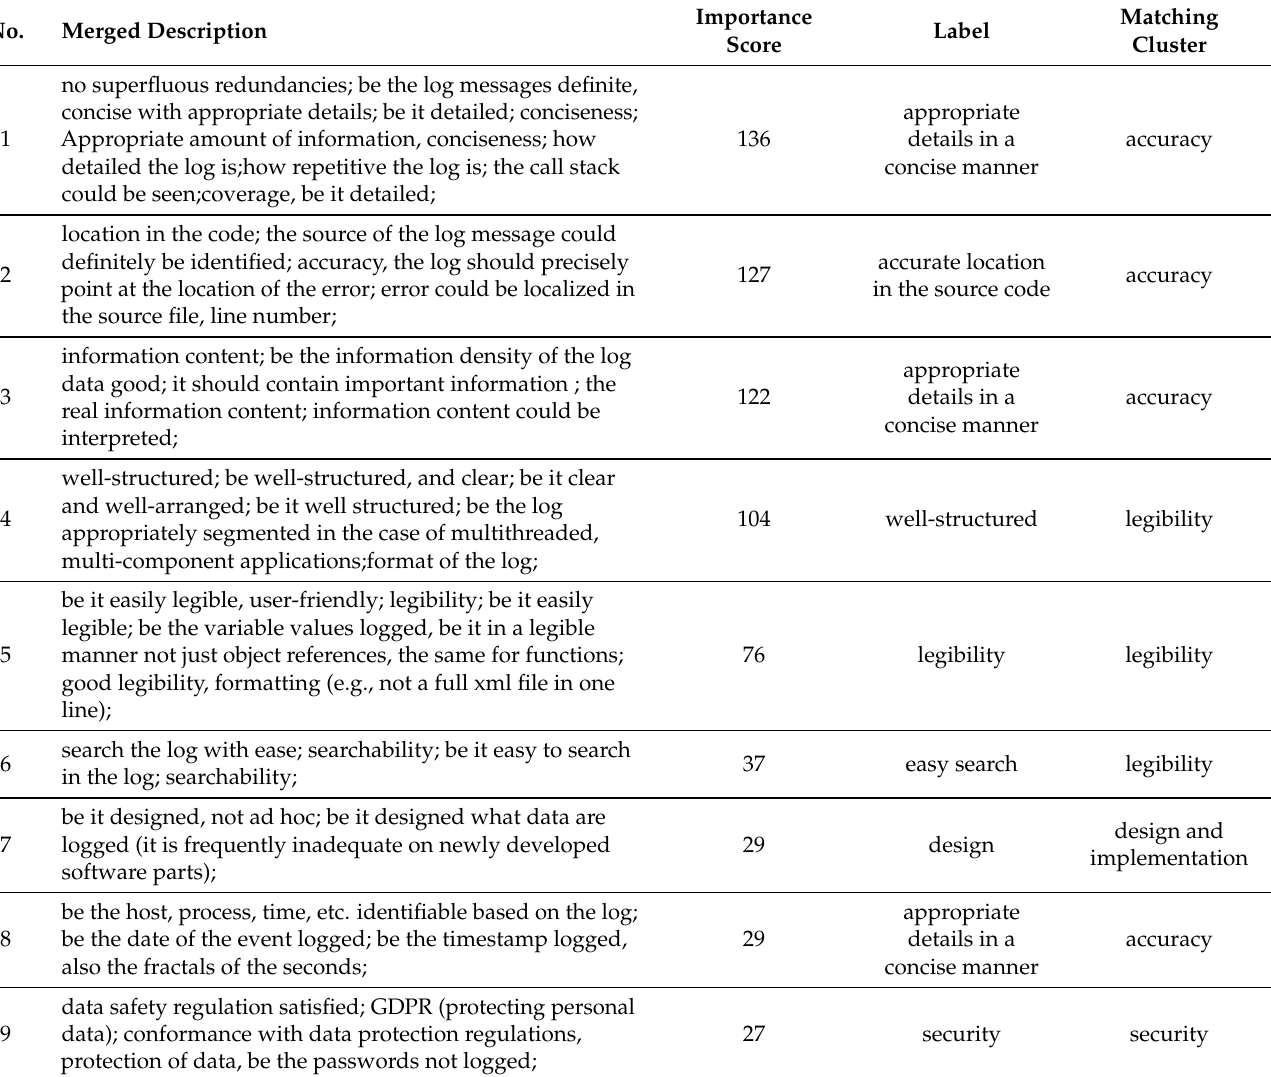
Table A1. List of the Execution Tracing Quality Property Candidates, Data